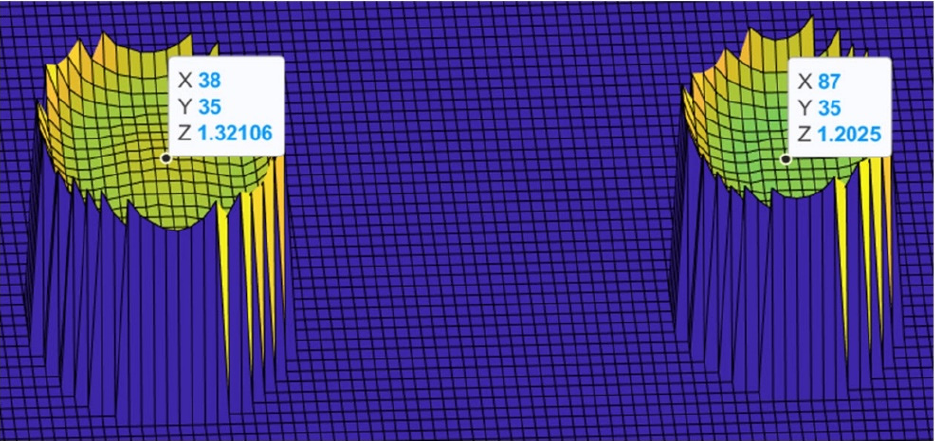
Figure 13. The result of estimated profile of two flat defects.